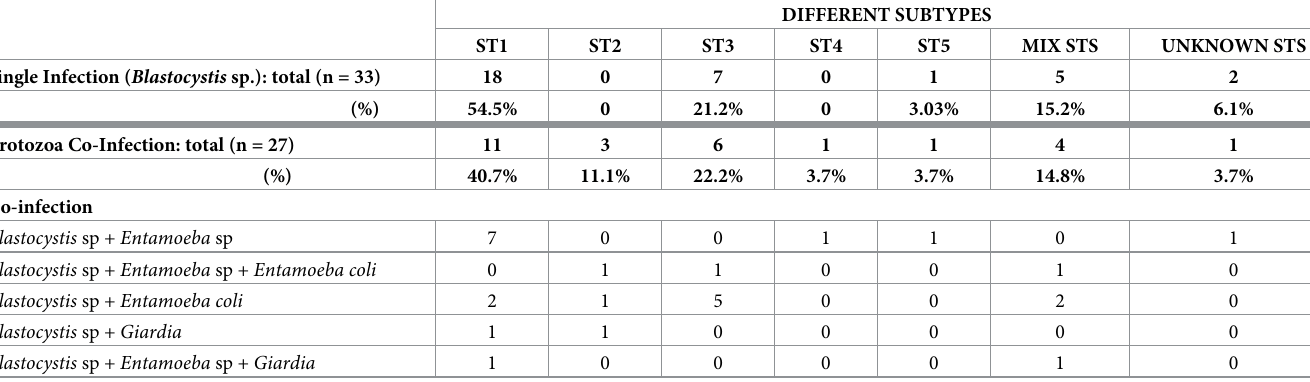
Table 2. The prevalence of Blastocystis subtypes with/without other intestinal parasites infections.